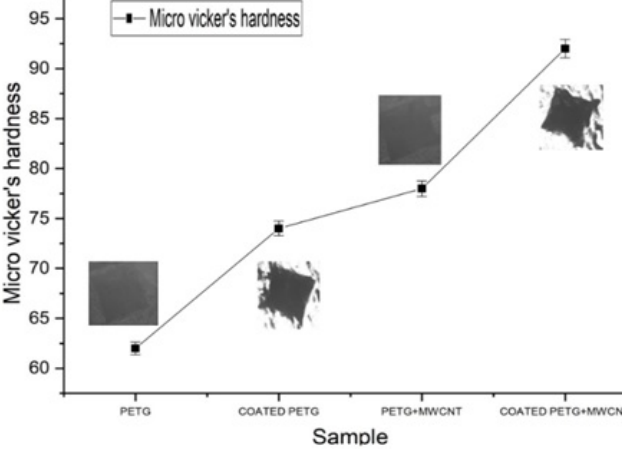
Figure 20. Micro-Vickers hardness for various PETG samples.